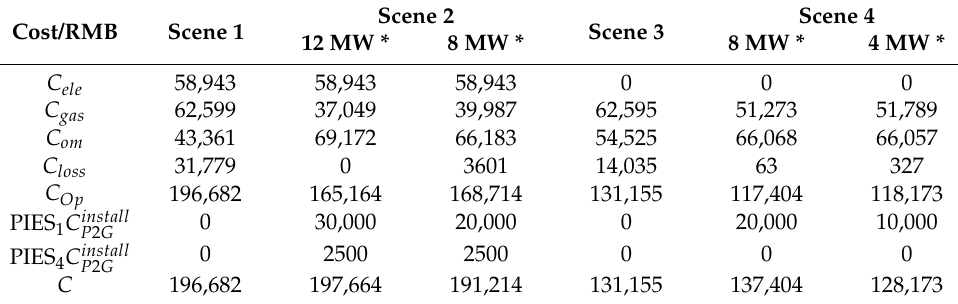
Table 2. Costs of a RIESG under different scenarios